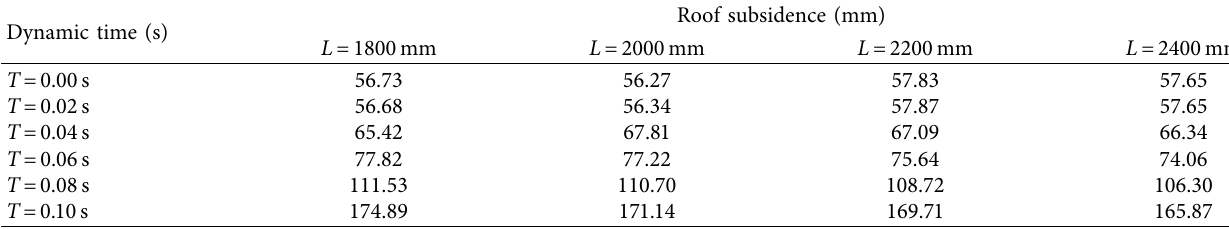
Table 6: Roof subsidence with different bolt lengths.